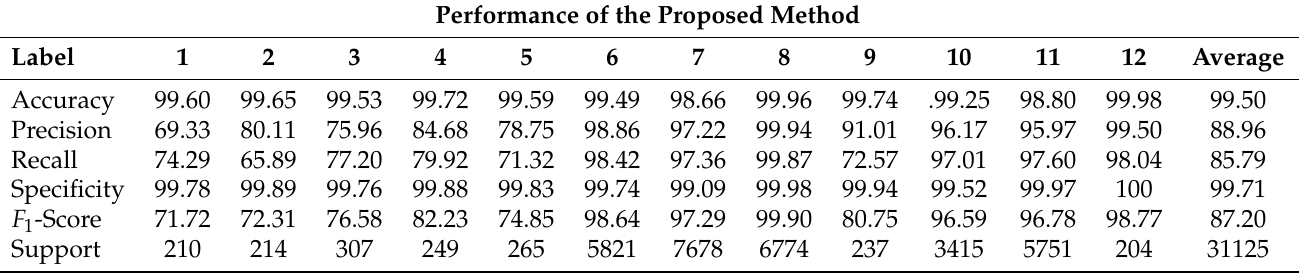
Figure 7. Training data for the BERT+TABGAN model. Table 5. Performance (%) obtained by the BERT+TABGAN model of the activity recognition system using